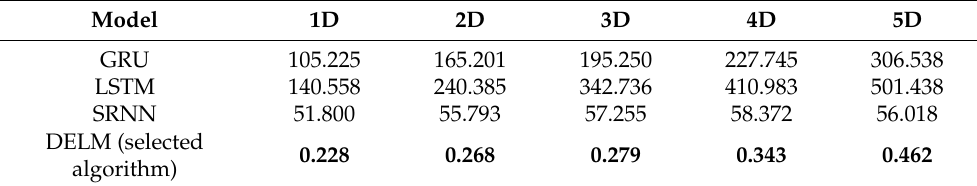
Table 3. CPU time for both training and testing sets of different models (s) *.